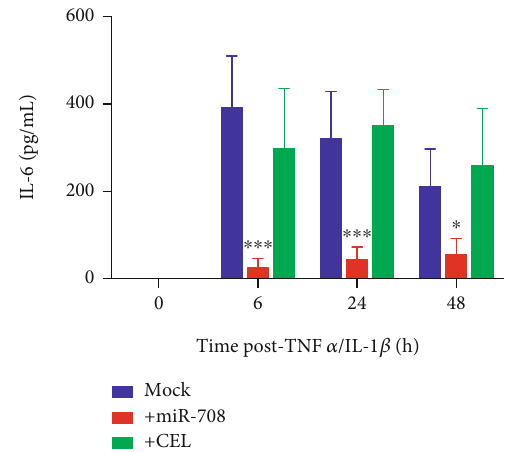
Figure 4: miR-708 suppresses TNF α /IL-1 β induced IL-6 expression independent of COX-2 signaling. ELISA measuring exogenous IL-6 levels in A549 cells cotreated with vehicle (blue), 25nM miR-708 (red), or 10 μ M CEL (green) and TNF α /IL-1 β for 0 – 48 hours. ∗ p < 0 : 05 and ∗∗∗ p < 0 : 001 , n ≥ 3